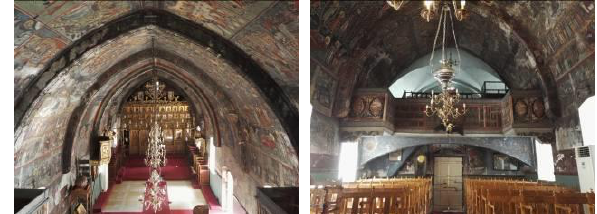
Figure 4. Main nave views towards the iconostasis (left) and the women’s gallery (right)